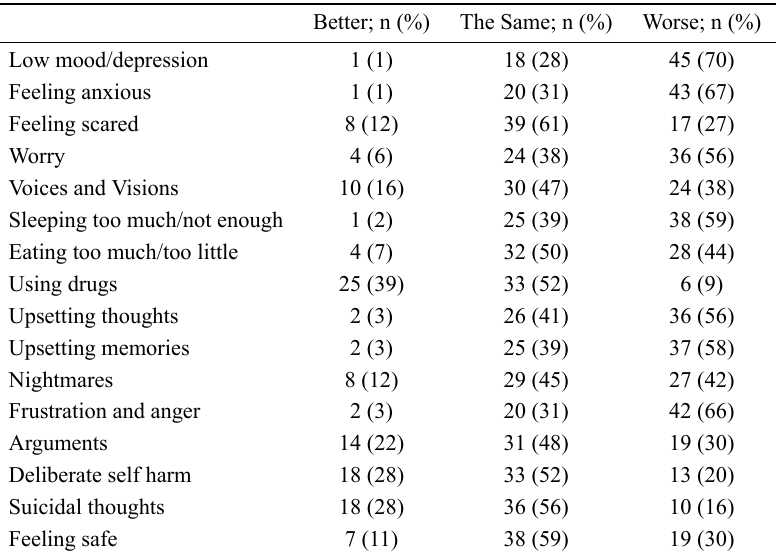
Table 2. The impact of SARS-CoV-2 related changes and stressors on mental health outcomes among prisoners; frequencies and